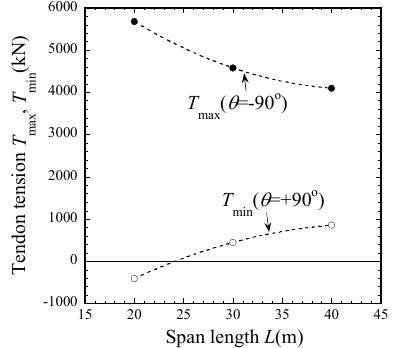
Fig. 10 Tendon tension dependency on L ( D p : H p = 6 m: 23 m, T 0 = 2290 kN, under storm